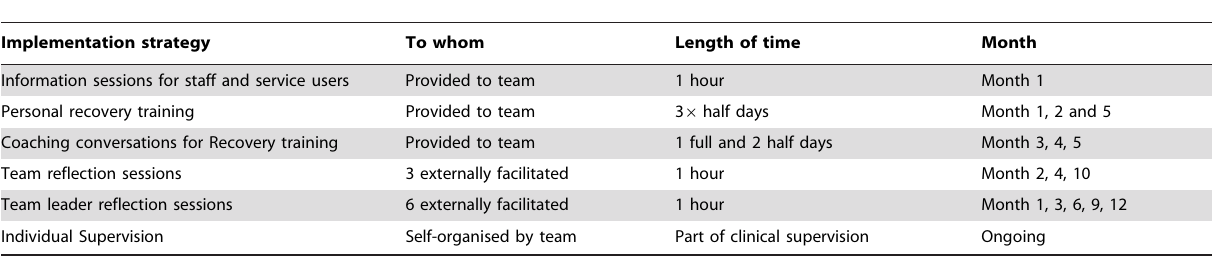
Table 2. Summary of REFOCUS implementation